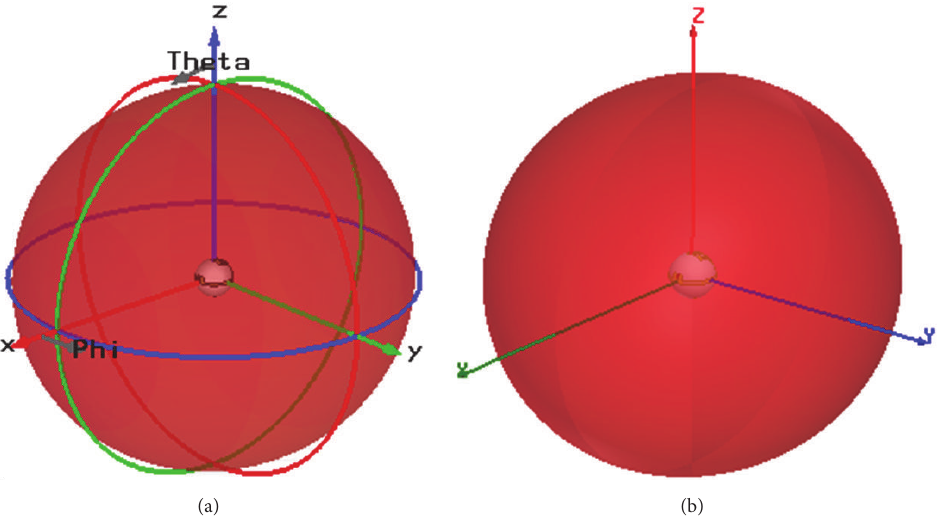
Figure 31: Radiation patterns ( 𝐸 total ) in 3D of the 3D spherical antenna (Table 11): (a) CSE and (b) HFSS.